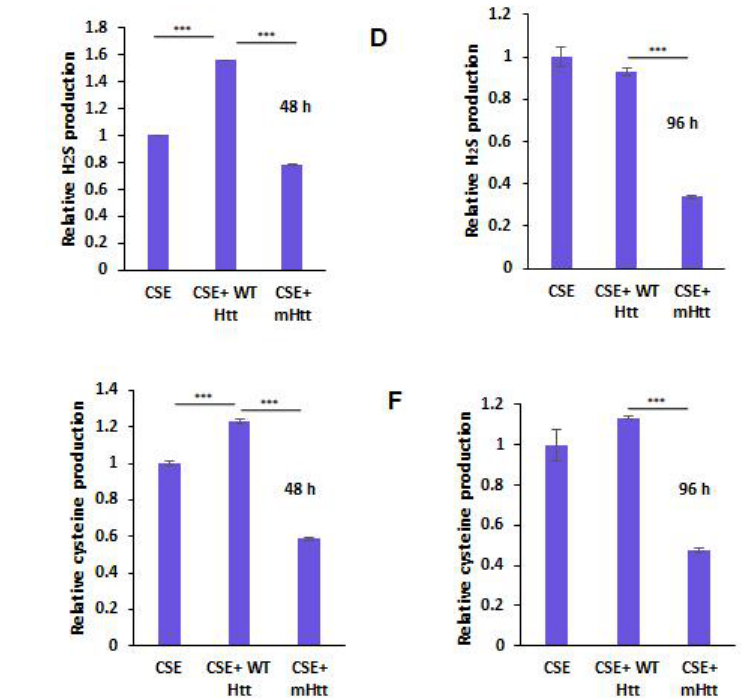
Figure 4. Mutant huntingtin (mHtt) binds cystathionine γ -lyase (CSE) and inhibits its catalytic activity. ( A ) Interaction of CSE with huntingtin. HEK293 cells were transfected with constructs encoding myc-tagged CSE and either HD17 or HD75 for 24 h and immunoprecipitation conducted using anti-myc antibody. CSE bound both wild-type and mutant Htt. ( B ) Expressions of CSE, WTHtt, and mHtt at 48 and 96 h post-transfection as determined by Western blotting. ( C , D ) Activity of CSE at 48 and 96 h, respectively, as measured by assaying H 2 S production from 10 mM L-cysteine in the presence of the cofactor, pyridoxal 5-phosphate (PLP at 250 mM), using the methylene blue assay. ( E , F ) Enzymatic activity of CSE at 48 and 96 h respectively, as measured by assaying cysteine production from cystathionine in the presence of the cofactor, pyridoxal 5-phosphate (PLP at 250 mM), using the ninhydrin assay. n = 3, SEM, * ** p < 0.001.